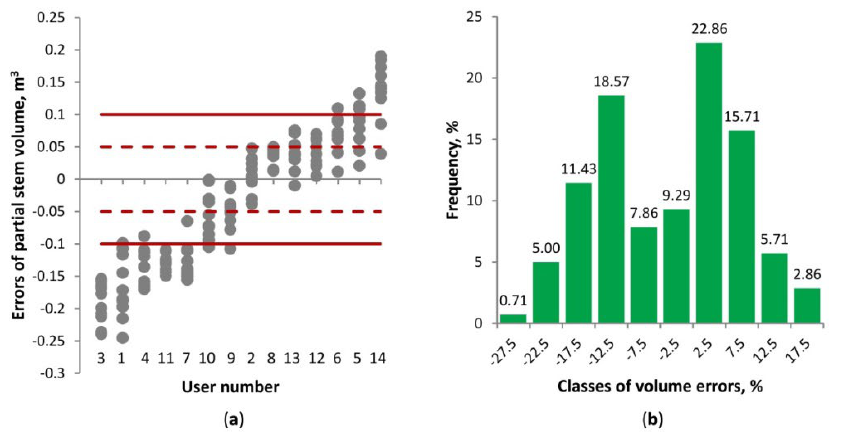
Figure 4. Errors variation ( a ) and histogram of errors ( b ) in partial stem volume estimated with Huber’s formula when using a laser caliper. The red lines enclose the values with the error range of ±0.1 m 3 in relation to the true volume and the red dashed lines enclose the values with the error range of ±0.05 m 3 in relation to the true volume.